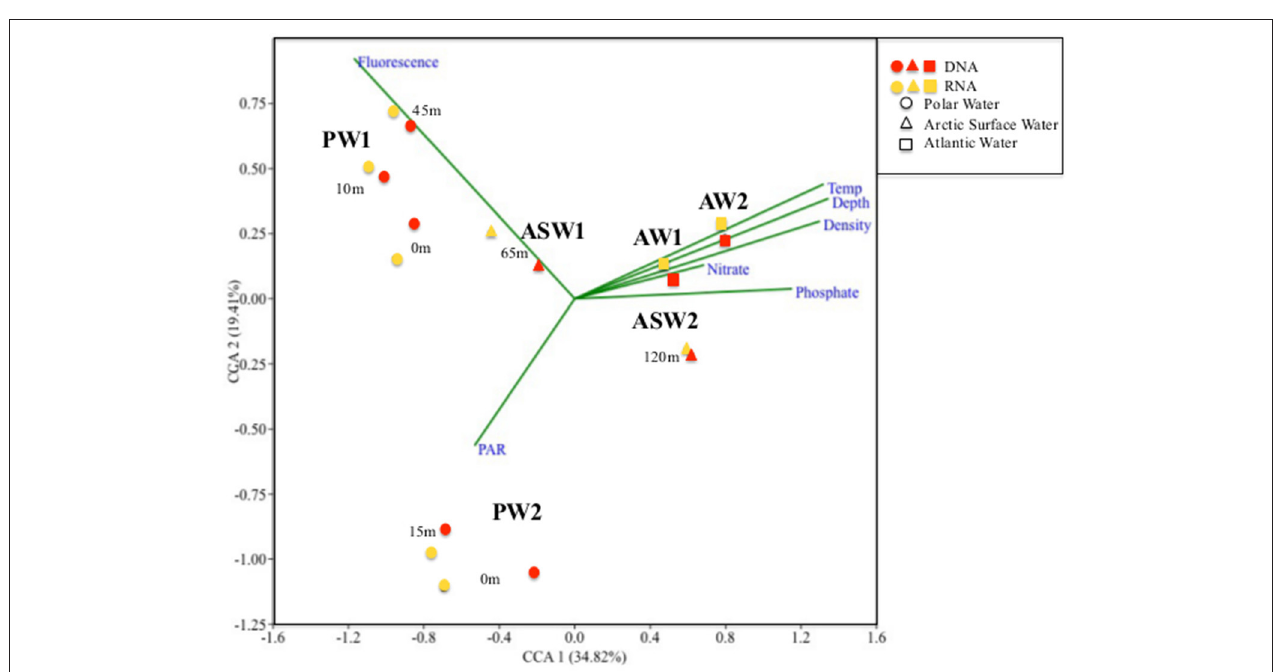
FIGURE 4 | Canonical Correspondence Analyses (CCA) ordination diagram of the 18 samples collected at different depths from Stations 1 and 2. PW, Polar Water; ASW, Arctic Surface Water; and AW, Atlantic Water. 1 and 2 refers to the respective Station numbers (i.e., PW1-Polar Water samples from Station1). Arrows represent the best explanatory environmental and biological variables fitted onto the ordination space.